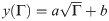
Refined data analysis for local marriages in France.Panel a: log-log scale plot of LMαi,y versus Γαi,y, where different regions are denoted in different colours and symbols, as explained in the legend. These data are properly binned (green squares) and best-fitted (solid line) by y(Γ)=aΓ+b, in agreement with the theoretical result (2). The best-fit coefficients are a = 1.87 and b = −4.38 ⋅ 10−4. The parameter b is introduced to account for the error (calculated in terms of the standard deviation) associated to binned data, which is ≈ 5%. In general, the various regions seem to be homogeneously scattered around the best-fit curve. In the insets we show, as examples, the data pertaining to two selected regions, namely Limousin (upper inset) and Provence-Alpes-Cote d’Azur (lower inset). Notice that for both the insets, the best-fit previously obtained for the whole data set (solid line) still provides a proper fit. Panel b: For each region we calculate ρ
α, as defined in the text and deepened in the Theoretical Protocol Section. The horizontal line is drawn as a reference for the unitary value. Notice that the largest deviation from the unitary value is for Corsica. From this plot we can distinguish regions displaying a relatively large number of marriages (i.e., ρ
α > 1) and regions displaying a relatively small number of marriages (i.e., ρ
α < 1). This division is highlighted in the colormap presented in panel c. Interestingly, regions exhibiting analogous deviations share a certain degree of geographical proximity: regions with ρ
α > 1 (dark shading) correspond to the North-Eastern border of France, while regions with ρ
α < 1 (bright shading) correspond to the Center-Western part of France. Panel d: the two clusters of regions highlighted are analyzed separately. For each we bin the related raw data and get a best fit, still according to the function y(Γ)=aΓ+b, obtaining a
up = 1.90 and b
up = −6.5 ⋅ 10−5 (R
2 = 0.97) for the set of regions with ρ
α > 1, and a
down = 1.68 and b
down = −2.2610−4 (R
2 = 0.98) for the set of regions with ρ
α < 1; notice that a
up/a
down ≈ 1.1. Binned data for the former set (triangles) and for the latter set (square) are shown in the main panel, together with the related best fits, in a log-log scale plot. These fits are slightly better that the one obtained at the country level, suggesting that possible internal heterogeneities may be rather limited. In the insets we compare these best fits with raw data for two regions (Aquitaine and Auvergne) with ρ
α > 1 (upper inset) and two regions (Alsace and Franche-Comté) with ρ
α < 1 (lower inset). Notice that in both cases data points overlap both curves, again suggesting that the division highlighted here is rather mild.